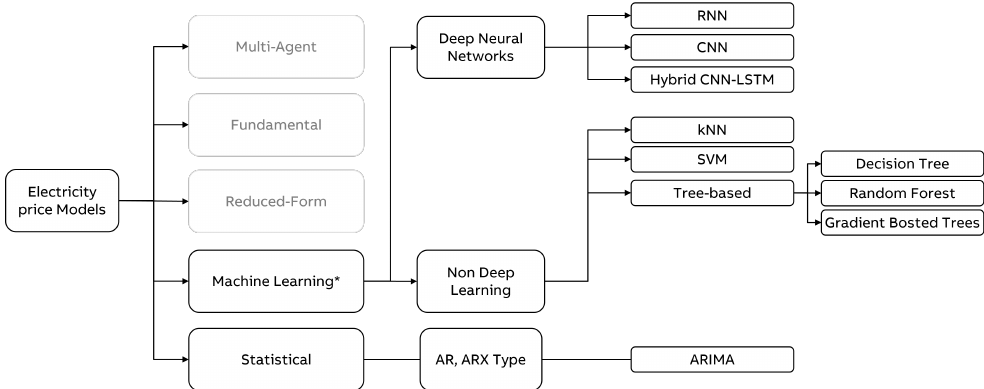
Figure 2. The approaches evaluated in this work in the context of the taxonomy adapted and modified from Weron et al. (* The model class computational intelligence has been extended and renamed)